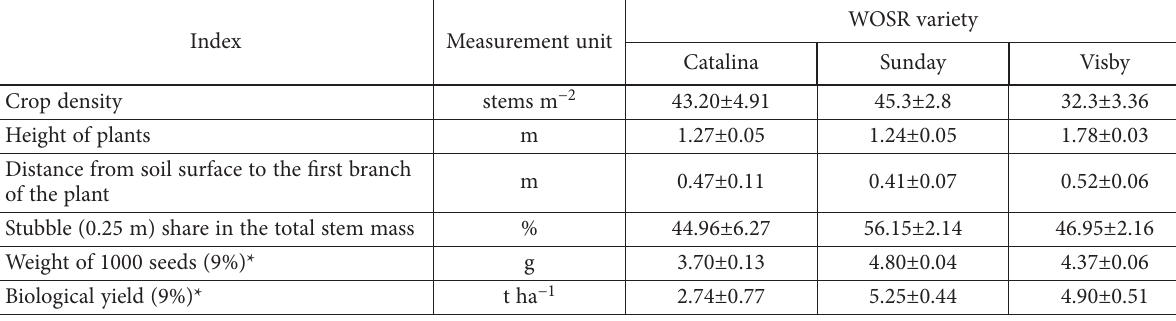
Table 4. Biometric indices of winter